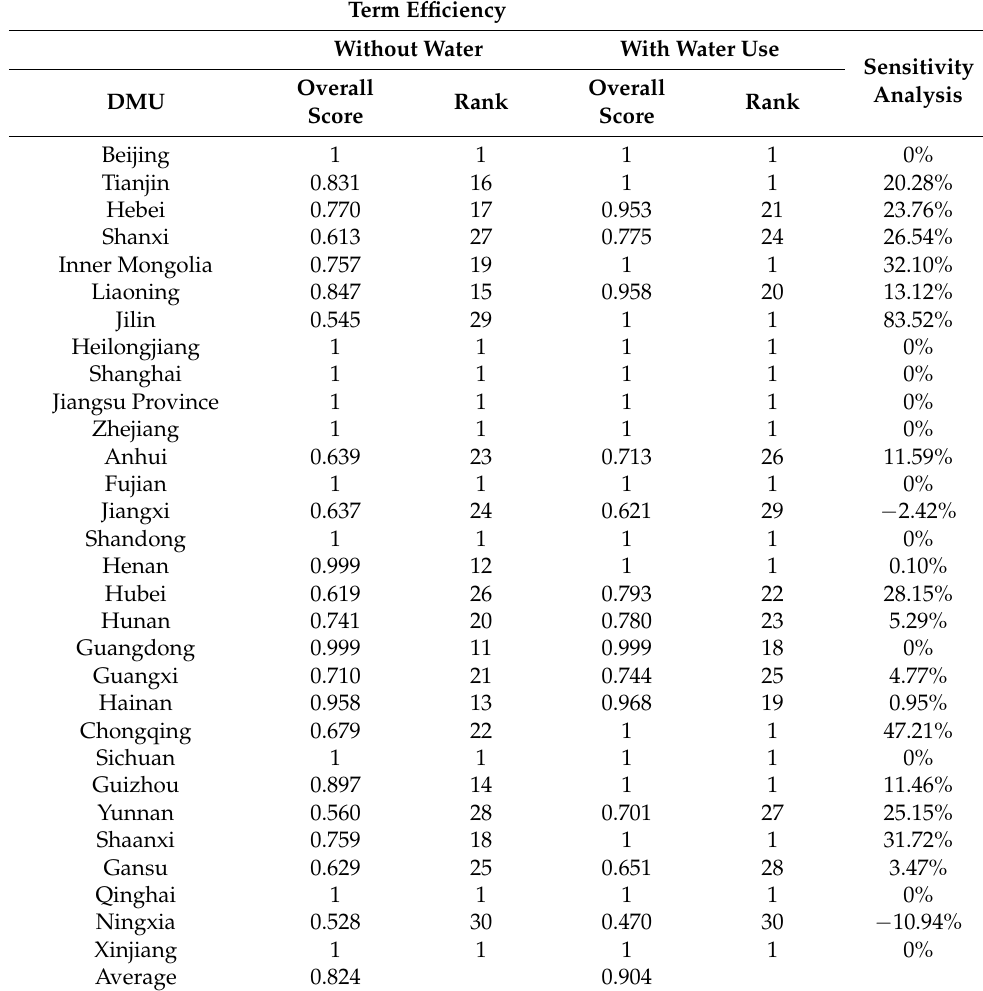
Table A1. Sensitivity analysis of overall agricultural efficiency in China’s administrative regions from 2012 to 2016.